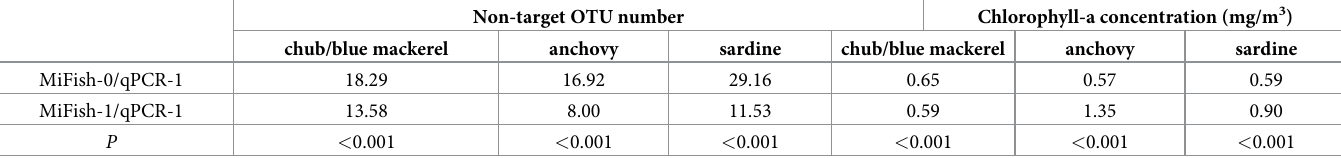
Table 2. Difference of non-target OTU number (average per sample) and chlorophyll-a concentration (average per sample) between MiFish-0/qPCR-1 and MiFish- 1/qPCR-1